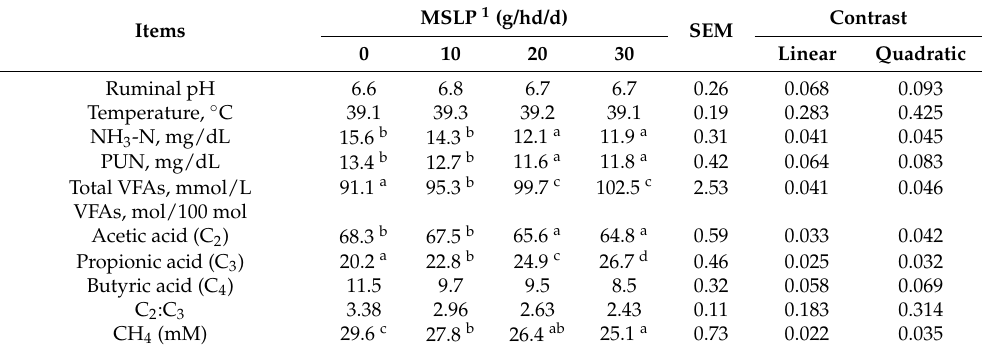
Table 3. Effect of Mitragyna speciosa Korth leaf pellet supplementation on fermentation characteristics and plasma urea nitrogen in Thai native beef